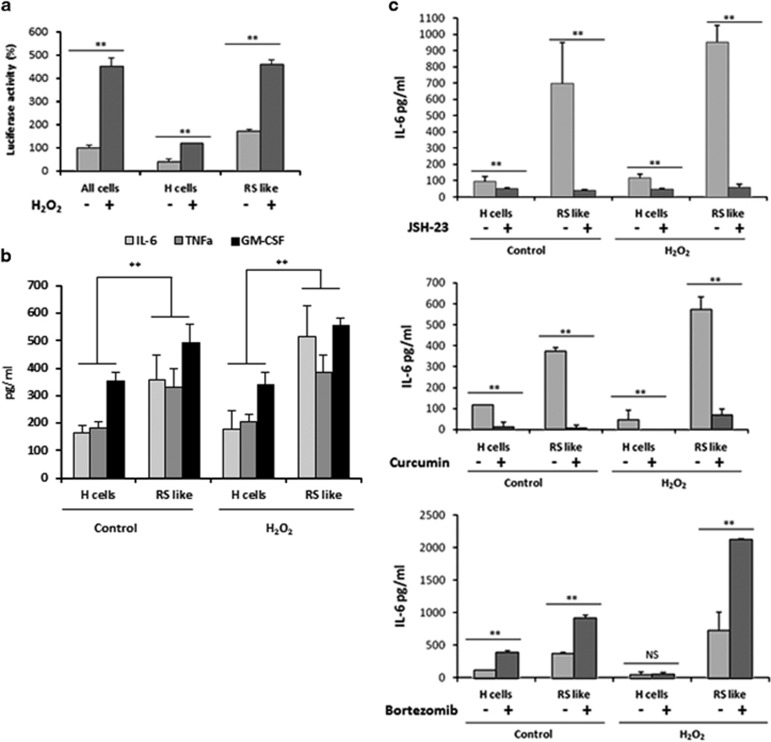
RS-like cells exhibit high NF-κB activity. (a) NF-κB luciferase activity was determined in non-sorted L428 cells and in FACS-sorted H and RS cells in the presence or absence of H2O2 as described in Materials and Methods. (b) RS like cells are the main source for cytokine secretion. Control and H2O2 treated cells were FACS sorted as in (a). Supernatants were collected 24 h after plating followed by ELISA. Large RS cells expressed higher levels of IL-6, GM-CSF and TNF-α compared with H cells (calculated for each individual cytokine). (c) NF-κB is a modulator of IL-6 production in RS cells. Control and H2O2-treated cells were FACS sorted as in a. The specific NF-κB inhibitor JSH-23 (100 μM), Curcumin (30 μM) and Bortezomib (10 nM), were added to sorted cells and supernatants were collected after 24 h. IL-6 was determined in triplicates by ELISA and normalized to 106 cells. The experiments were repeated three times and mean and ±S.D. were calculated. Significance of at least **P<0.05 was determined by t-test